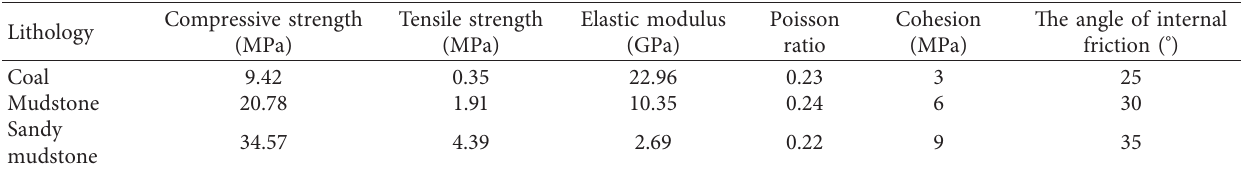
Figure 1: The numerical model schematic diagram of different hole shapes. Table 1: Rock mechanics parameters and model stress conditions of three